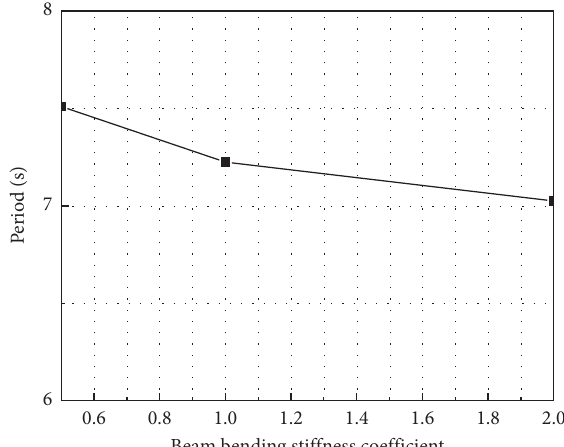
Figure 13: Influence of the beam section bending stiffness (0.6–2) on the period. Table 2: Influence of ignoring the normal floor beam on the structure period. Without the normal With the normal floor floor beam beam l Structural 7.3 7.3 period (s) Table 3: Influence of the core wall bending stiffness on the structure period. Without the With the flange wall flange wall Structural period (s) 7.3 6.3